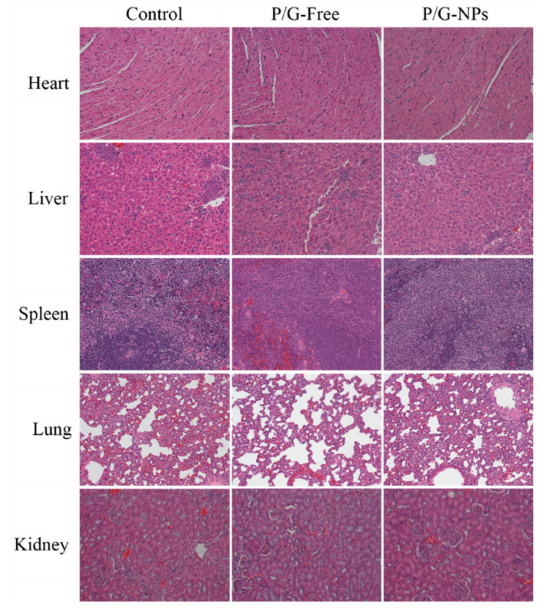
Figure 10. H&E staining of the PBS, P/G-Free, and P/G-NPs groups (20 ×